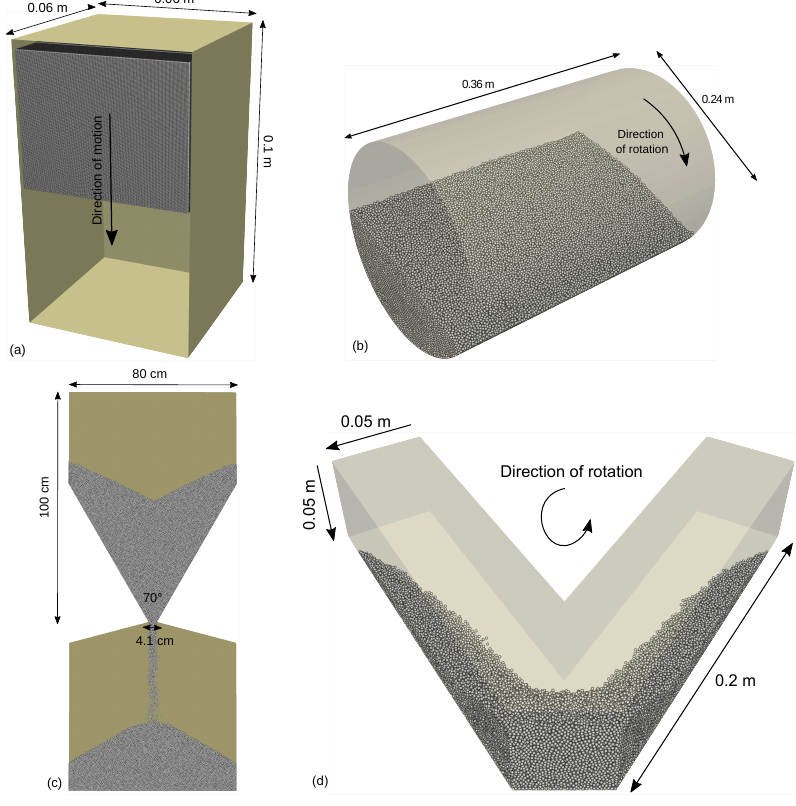
Figure 2. Configurations of the benchmark cases used in this work: ( a ) packing of particles in a rectangular box, ( b ) rotating drum [32], ( c ) silo filling and discharge [31], ( d ) V